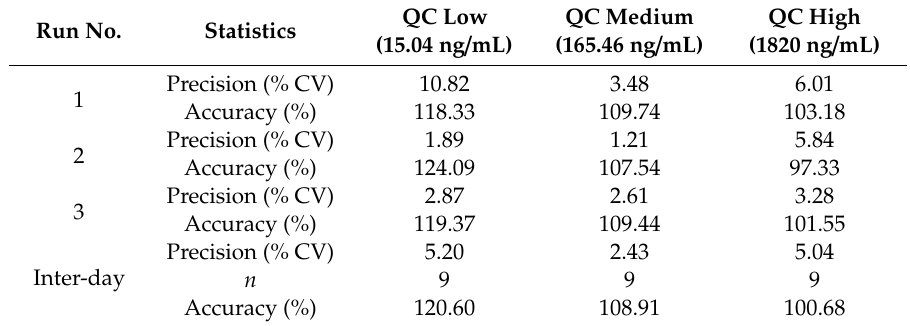
Table 1. Inter- / intra-day accuracy and precision of SCH 58261 in quality control samples ( n = 3).